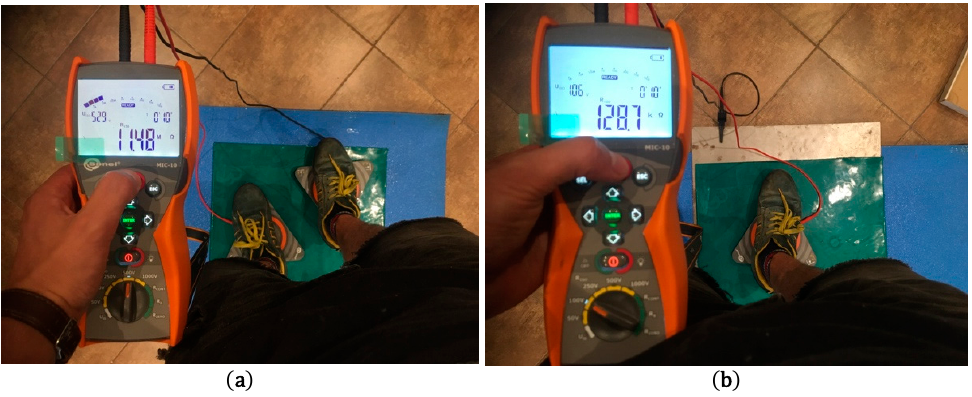
Figure 10 . ( a ) Point-to-point and ( b ) vertical resistance measurement . Figure 10. ( a ) Point-to-point and ( b ) vertical resistance